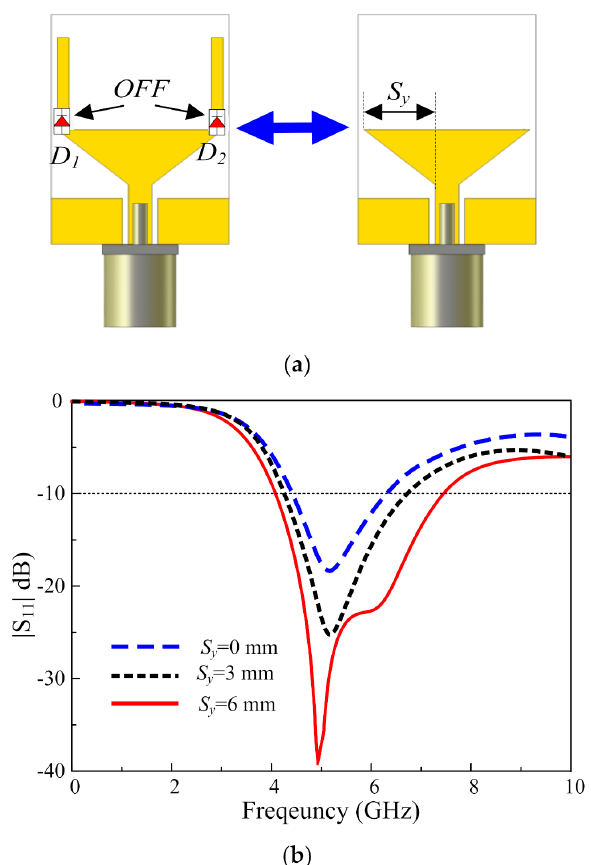
Figure 2. ( a ) Equivalent geometry and ( b ) simulated |S 11 | for different values of S y in the wide-band operating modes (both p-i-n diodes are OFF).